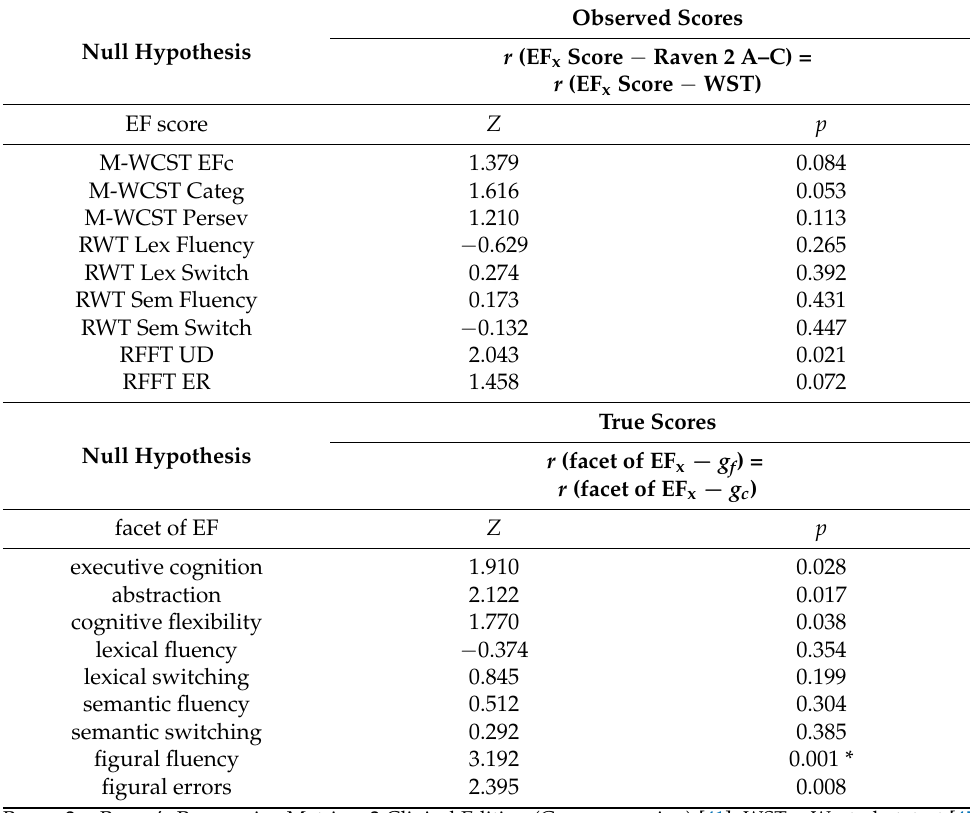
Raven 2 = Raven’s Progressive Matrices 2 Clinical Edition (German version) [41]; WST = Wortschatztest [45]; M-WCST = Modified Wisconsin Card Sorting Test [21]; EFc = Executive Function Composite; Categ = number of categories; Persev = number of perseverative errors; RWT = Regensburger Wortflüssigkeits-Test [46]; Lex Fluency = lexical fluency; Lex Switch = lexical switching; Sem Fluency = semantic fluency; Sem Switch = semantic switching; RFFT = Ruff Figural Fluency Test (German verison) [47]; UD = unique designs; ER = error ratio. p -values represent the statistical significance comparing two correlations with each other. Correlations were calculated according to Spearman’s rank-order correlations ( r xy ) for observed scores, and after application of Spearman’s attenuation formula ( r xtyt ) for true scores. * α